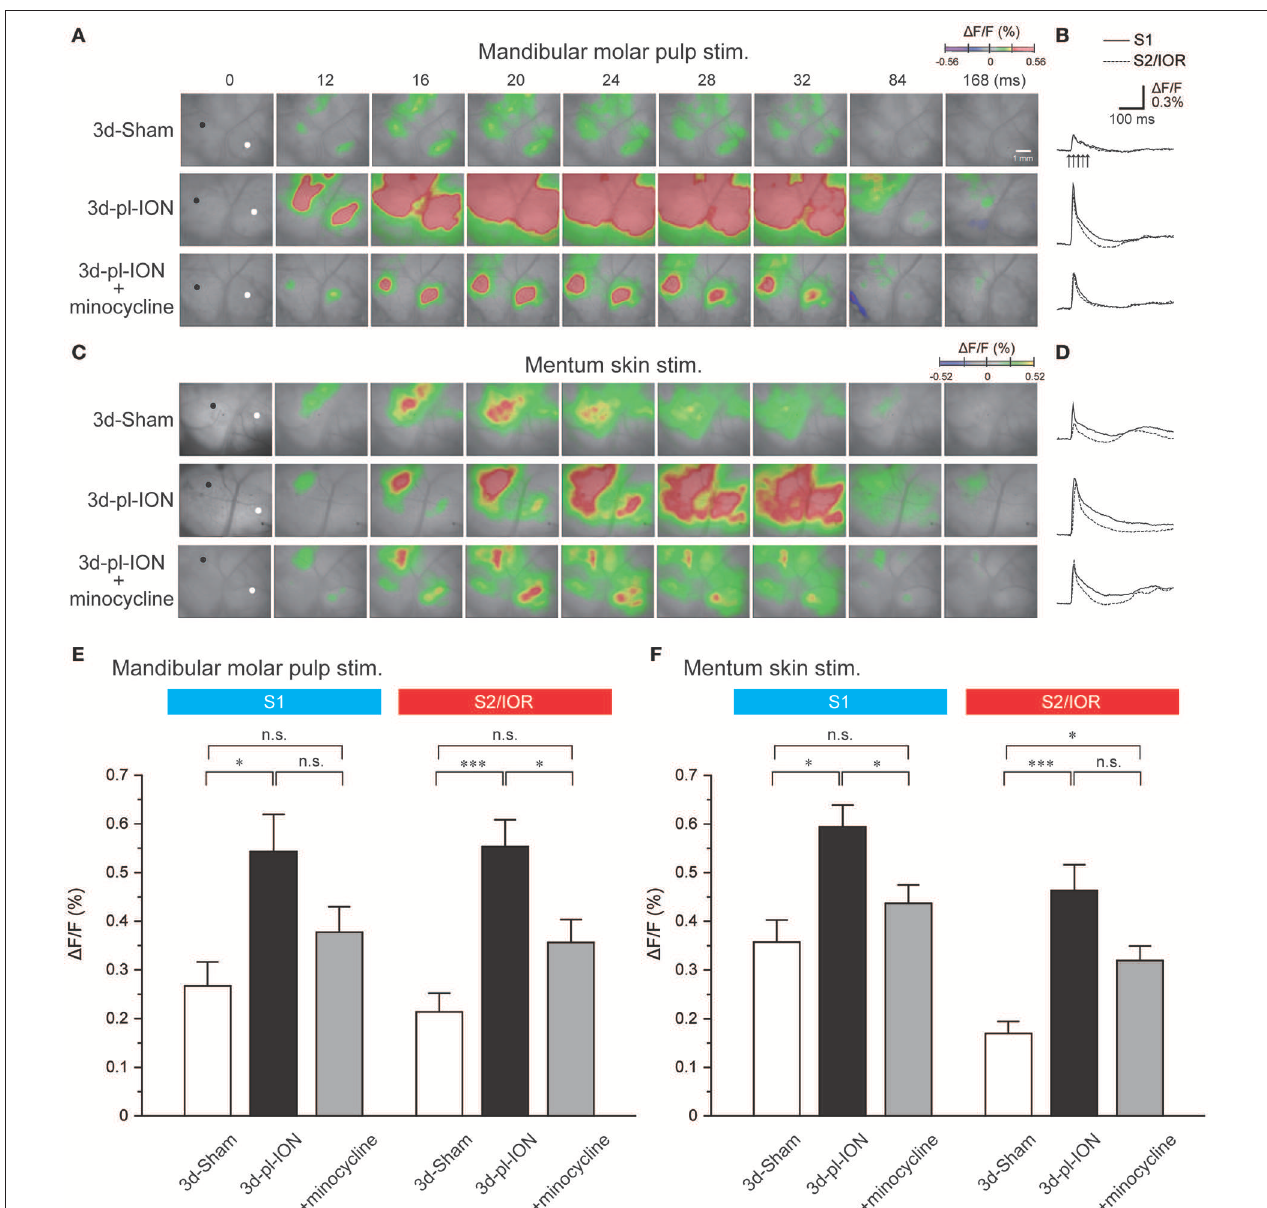
FIGURE 3 | Cortical responses to electrical stimulation of the mandibular molar pulp and mentum skin. (A) Representative examples of cortical responses in 3d-Sham, 3d-pl-ION, and 3d-pl-ION + minocycline to mandibular molar pulp stimulation. The time from the onset of the electrical stimulation of the whisker pad skin is shown on the top of each panel. (B) Temporal profiles of optical signals in the ROIs: black circles in S1 (thick lines) and white circles in S2/IOR (dotted lines) shown in (A) . (C) Representative examples of cortical responses in 3d-Sham, 3d-pl-ION, and 3d-pl-ION + minocycline to mentum skin stimulation. (D) Temporal profiles of optical signals in the ROIs: black circles in S1 (thick lines) and white circles in S2/IOR (dotted lines) shown in (C) . (E) The amplitude of S1 (blue) and S2/IOR (red) excitation in 3d-Sham ( N = 13), 3d-pl-ION ( N = 13), and 3d-pl-ION with minocycline ( N = 14) in response to stimulation of the mandibular molar pulp. (F) The amplitude of S1 (blue) and S2/IOR (red) excitation in 3d-Sham ( N = 7), 3d-pl-ION ( N = 15), and 3d-pl-ION with minocycline ( N = 15) in response to stimulation of the mentum skin. * P < 0.016, *** P < 0.001, n.s., not significant (Student’s t -test with Bonferroni